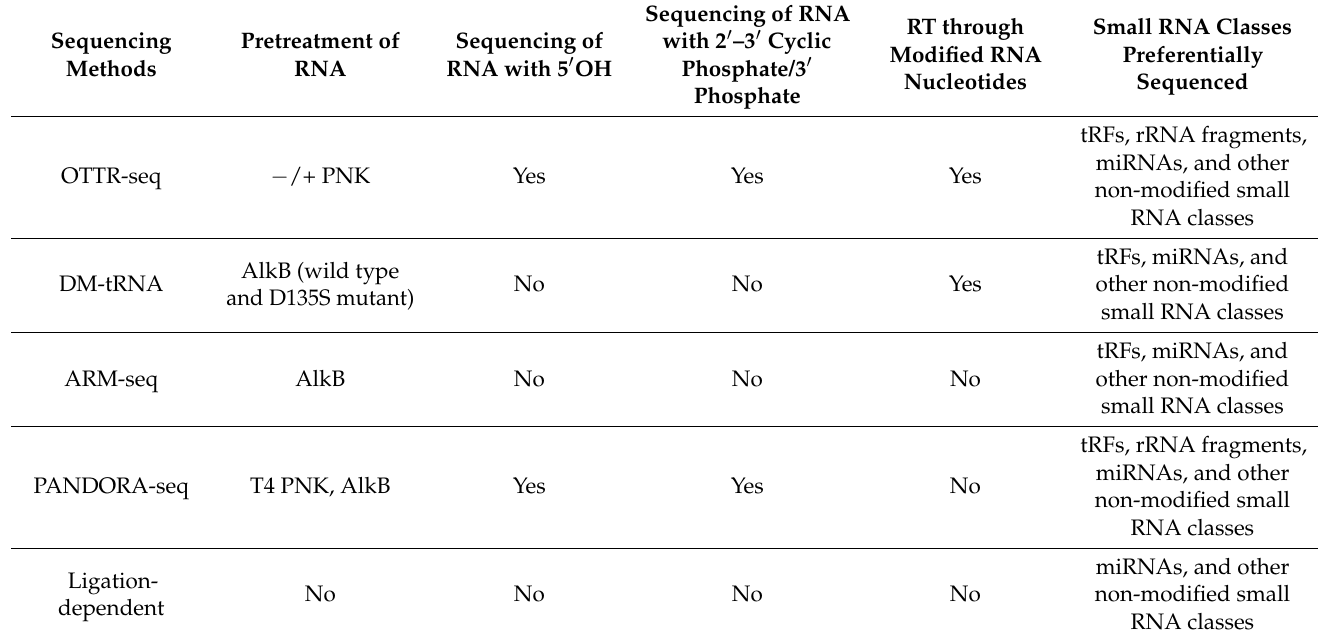
Table 1. Overview of the different sRNA-sequencing